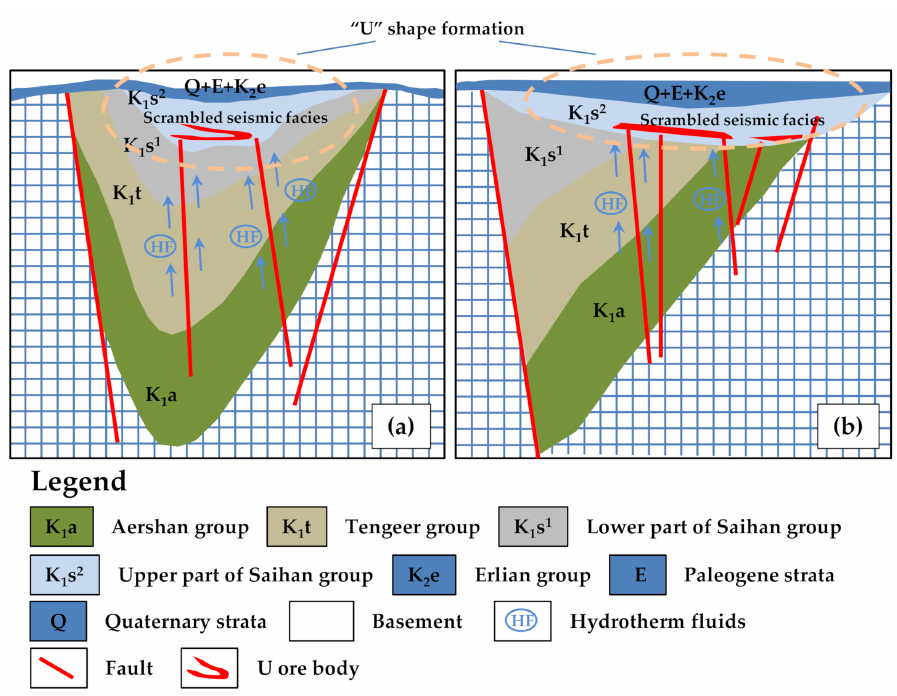
Figure 14. The prediction patterns of SUDs in the Erlian basin. ( a ) the Bayanwula pattern means “Big depression + fault”, ( b ) the Hadatu pattern means “Large-angle non-conformity +